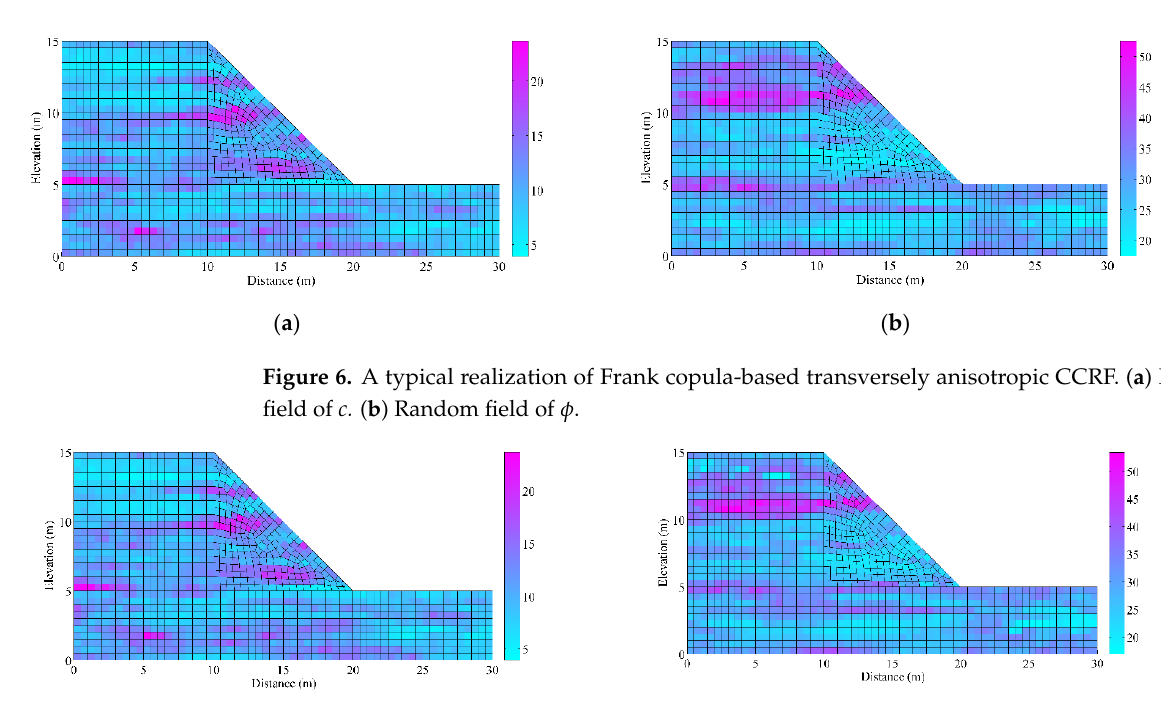
Figure 5. A typical realization of Plackett copula-based transversely anisotropic CCRF. ( a ) Random field of c . ( b ) Random field of ϕ.